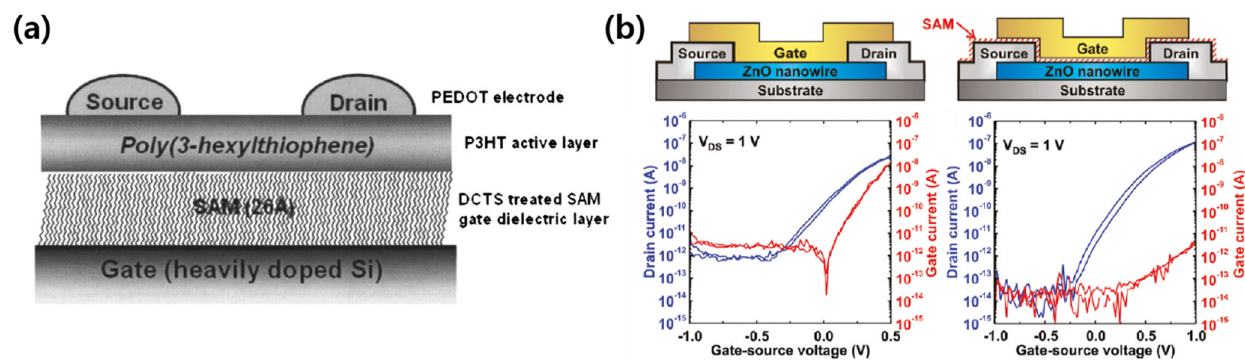
Figure 4. SAMs as gate dielectrics. ( a ) Schematic of P3HT transistor using docosyltrichlorosilane (DCTS) as a gate dielectric (adapted from [50] with permission from AIP Publishing). ( b ) Comparison of the electrical characteristics in MISFET and MESFET structures of ZnO nanowire FET with or without a SAM gate dielectric (adapted from [51] with permission from the American Chemical Society).